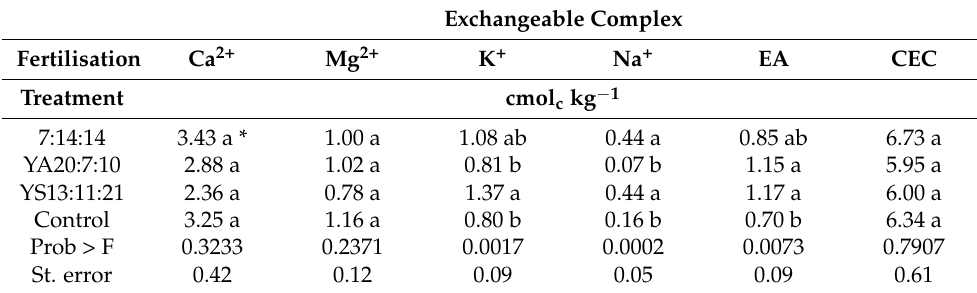
Table 4. Soil exchangeable bases, exchangeable acidity (EA) and cation-exchange capacity (CEC) as a function of fertilisation treatments.